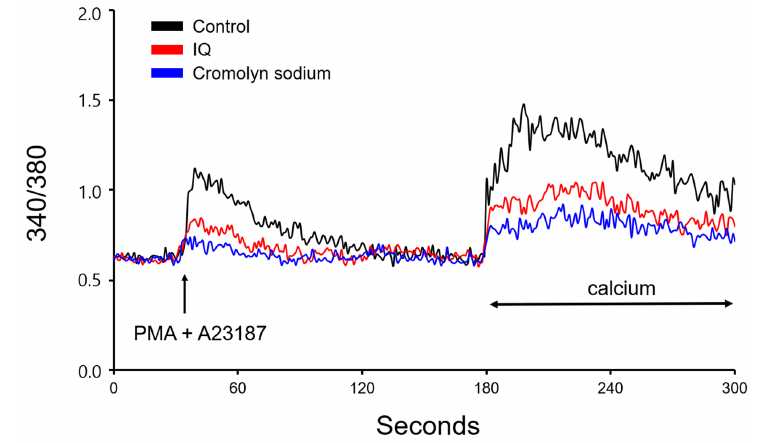
Figure 7. Effects of isoquercitrin (IQ) on PMA + A23187-induced intracellular calcium levels in HMC-1 cells. Intracellular calcium levels were measured for 300 s. PMA (20 nM) and A23187 (1 μM) was used to stimulate the HMC-1 cells. DMSO was used as a control.